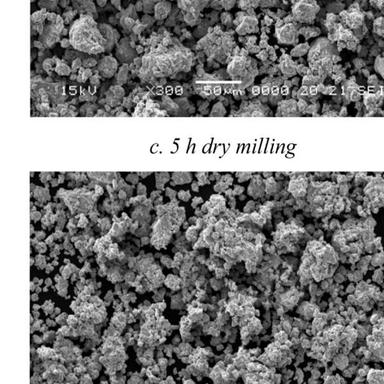
SEM images for starting sample and ball-milled powders in dry and wet milling conditions: a - starting sample (SS); b - 5 h wet-milled sample; c - 5 h dry-milled sample; d - 40 h wet-milled sample; e - 40 h dry-milled sample.